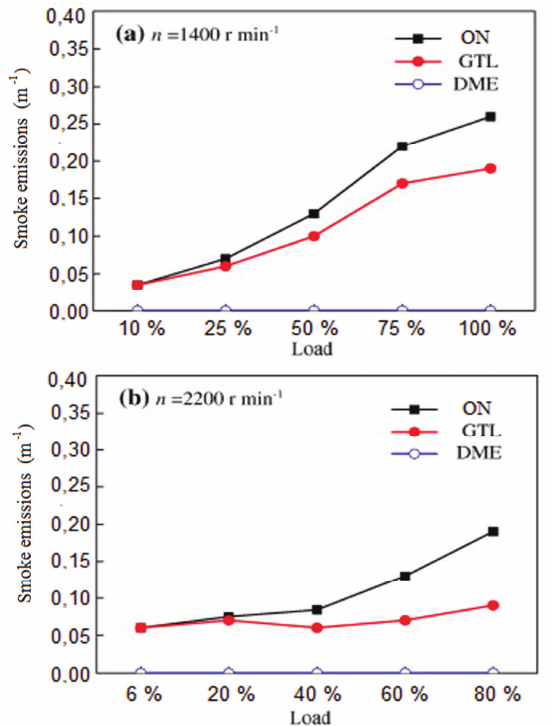
Fig. 5. Comparison of the smoke opacity when fueled with diesel fuel, GasToLiquid and DME under different conditions of engine operation [19]